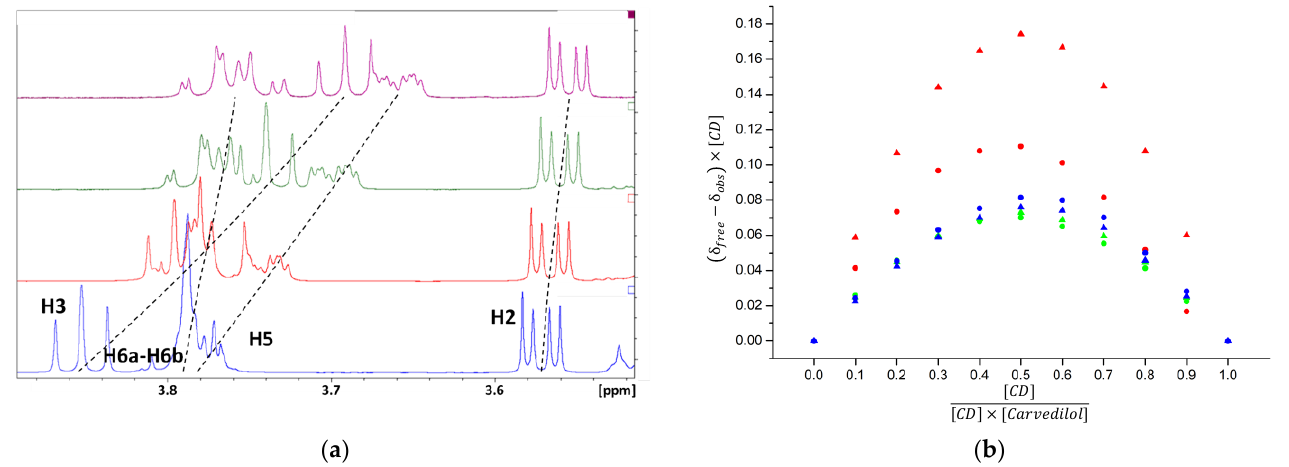
Figure 10. ( a ) Stacking of partial 1 H NMR spectra, corresponding to a Job plot for carvedilol/γCD in 0.1 M acetate -buffered D 2 O at the following γCD molar fractions: 1.0 ( ), 0.7 ( ), 0.4 ( ), 0.1( ). ( b ) A Job plot for a carvedilol/CD mixture obtained from 1 H NMR (600 MHz, 298 K). Observation of protons located inside the CD’s cavity: H3 βCD (